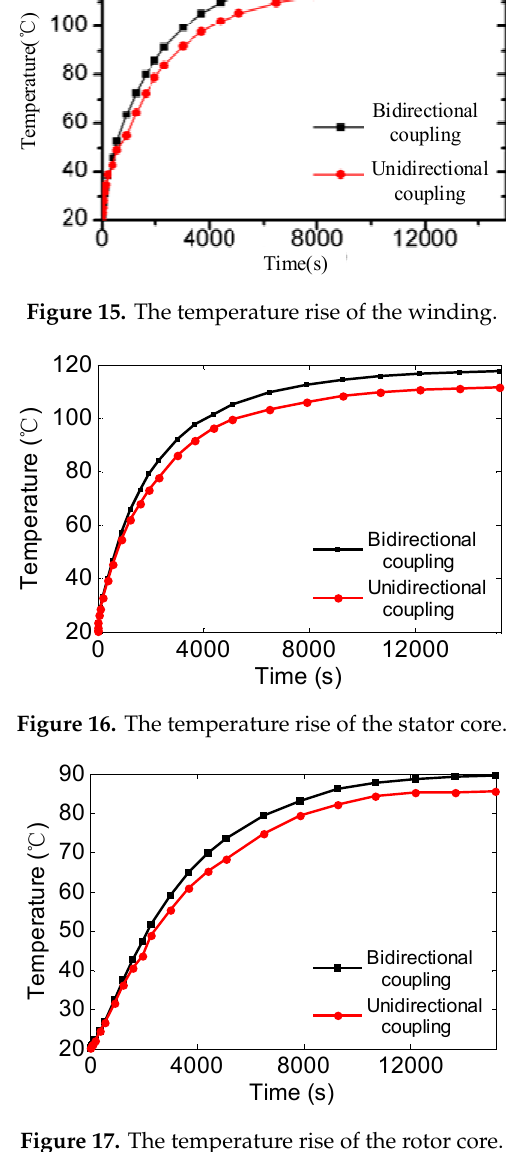
Figure 17. The temperature rise of the rotor core.